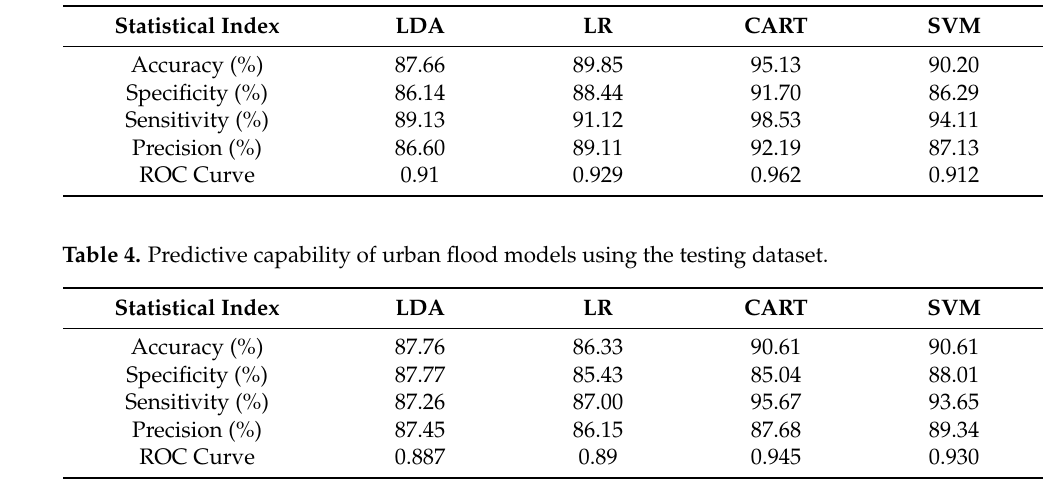
Table 3. Predictive capability of urban flood models using the training dataset.